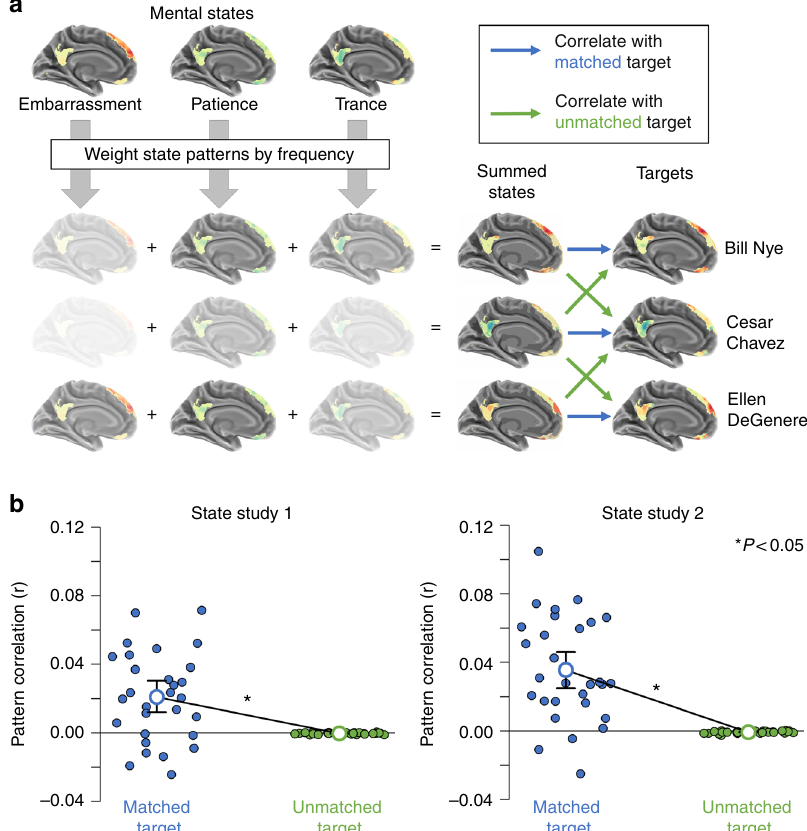
Fig. 1 People are represented as their summed states. a Schematic illustration of the analysis testing the summed state hypothesis: First, estimate mental state patterns within the social brain network using fMRI in State Studies 1 and 2. Second, weight these state patterns by how frequently each target person experiences each state (via multiplication). Third, sum the weighted state patterns to reconstruct target-speci fi c patterns. Fourth, compare the summed state patterns to target patterns, estimated in Person Study 1. Summed state patterns are compared via correlation to patterns for the correct target (matched, blue), and randomly selected targets (unmatched, green). b Results for State Studies 1 and 2: Summed states can accurately and speci fi cally reconstruct the patterns representing target people. The mean correlation (open circles) between reconstructed and actual target patterns was signi fi cantly greater for matched versus unmatched targets. Error bars represent 95% bootstrap con fi dence intervals computed separately around each mean. The matched datapoints (blue circles) comprise the average pattern correlation across 60 actual targets for each participant in the Person Study; unmatched datapoints (green circles) comprise the average pattern correlation across 3540 unmatched targets for each participant. P -values re fl ect the results of one-sample t -tests across participants on differences between matched and unmatched